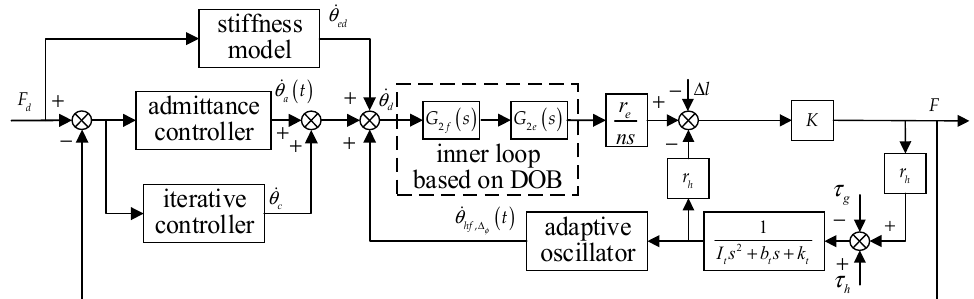
Figure 7. The system control block diagram.